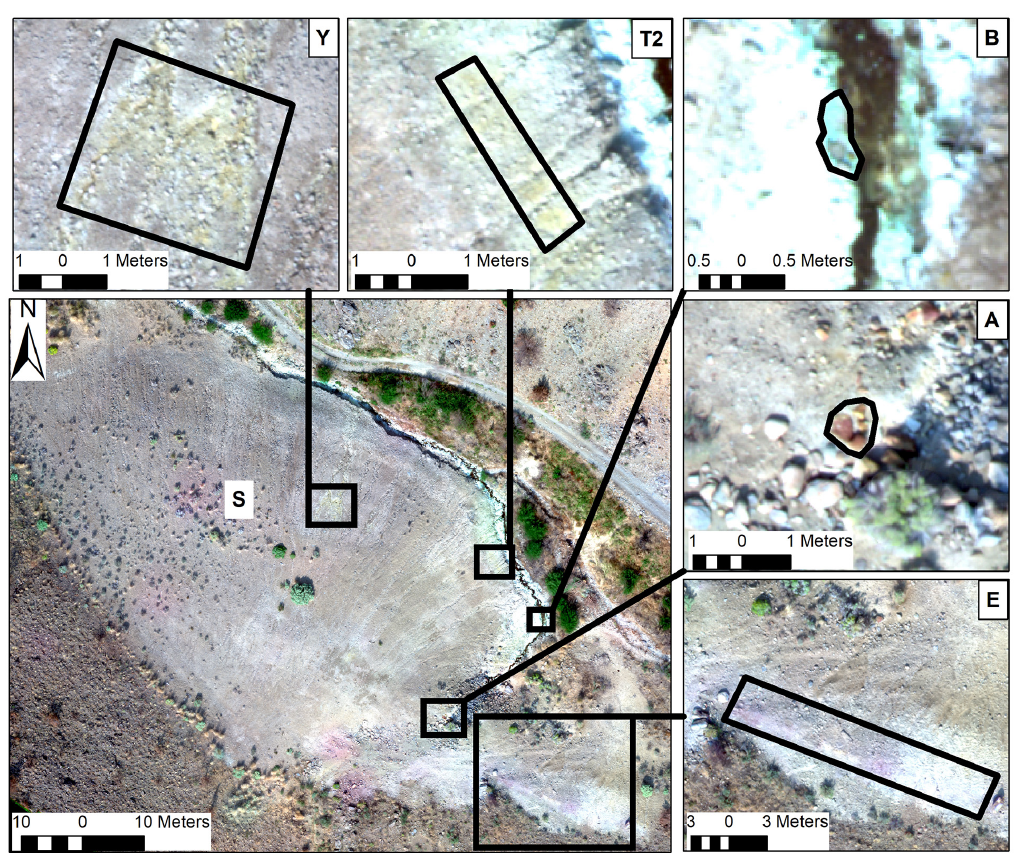
Figure 10. Locations for the field spectral measurements in October 2020. Y, T2, B, A, E, locations are represented by boxes on the October 2020 reflectance map, and the zoomed in images indicate the exact locations for spectra shown in Figure 11. S is the location of the second trench site.